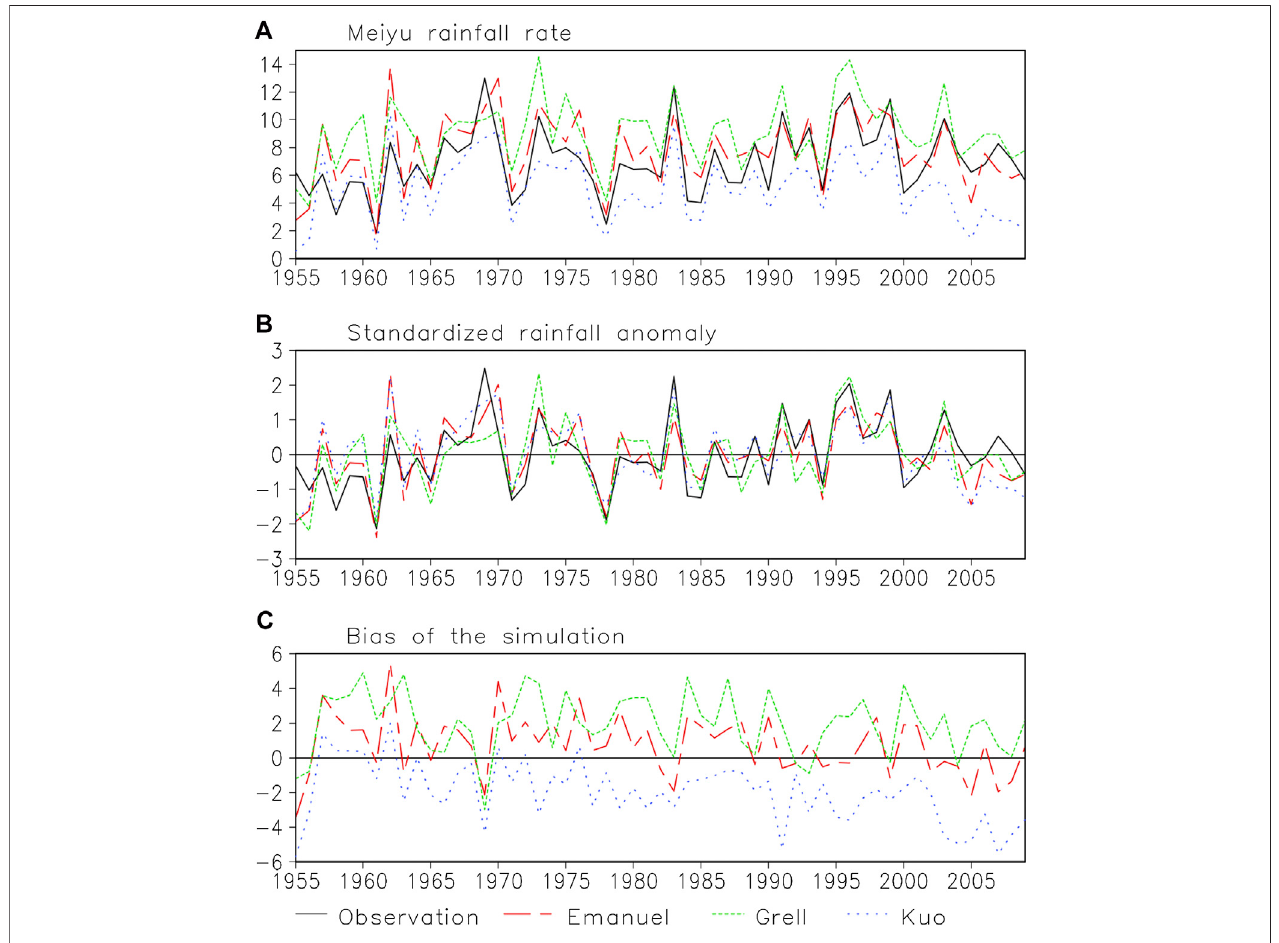
FIGURE2| (A) Observated(black solidline) and simulatedYangtzeMeiyu rated bythe Emanuel (red long-dashed line), theGrell(greenshort-dashed line), and the Kuo (blue dotted line) (unit: mm/d) schemes; (B) normalized anomalies; and (C) biases of simulations (unit: mm day). Annual precipitation is the area mean value of precipitation in the middle and lower reaches of the Yangtze River.